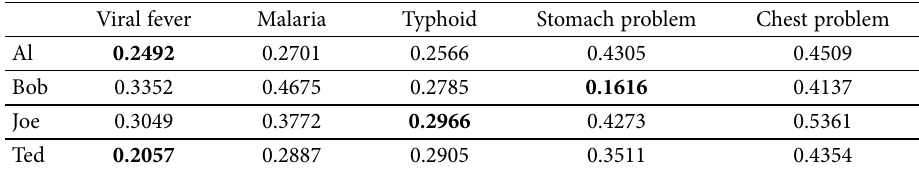
Table 7. Similarities symptoms (Spherical distance) for each patient to the considered set of possible diagnosis Viral fever